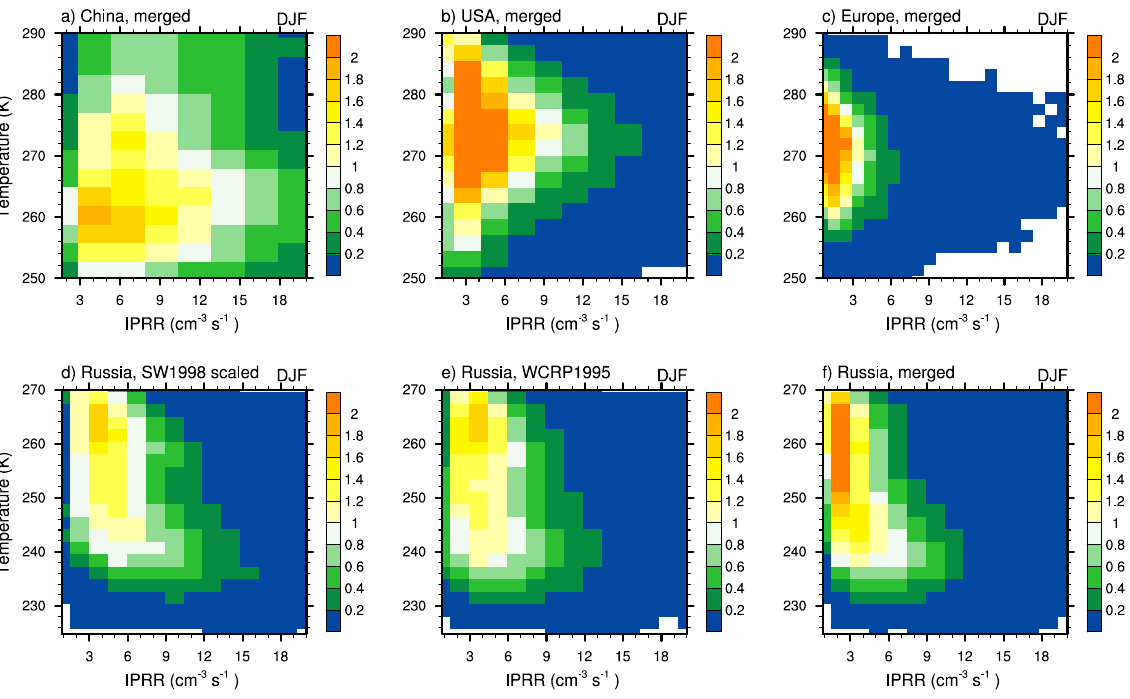
Fig. 14. Joint (bivariate) probability density distribution (PDF) of air temperature and radon-related ionization rate (IPRR) in different regions: (a) China (20 ◦ N–50 ◦ N, 75 ◦ E–120 ◦ E); (b) Europe (40 ◦ N–75 ◦ N, 10 ◦ W–40 ◦ E); (c) USA (30 ◦ N–50 ◦ N, 120 ◦ W–70 ◦ W); (d – f) Russia (50 ◦ N–80 ◦ N, 40 ◦ E–180 ◦ E). These regions are indicated by dashed black frames in Fig. 11. Labels next to the color bar are intensities of the PDF (unit:%). The PDFs are computed for the near-surface from the 3-hourly model output in winter months (DJF). Marginal area with white color indicate missing values. Note that scales of the temperature coordinate in (a – c) are not the same as those in (d – f) .